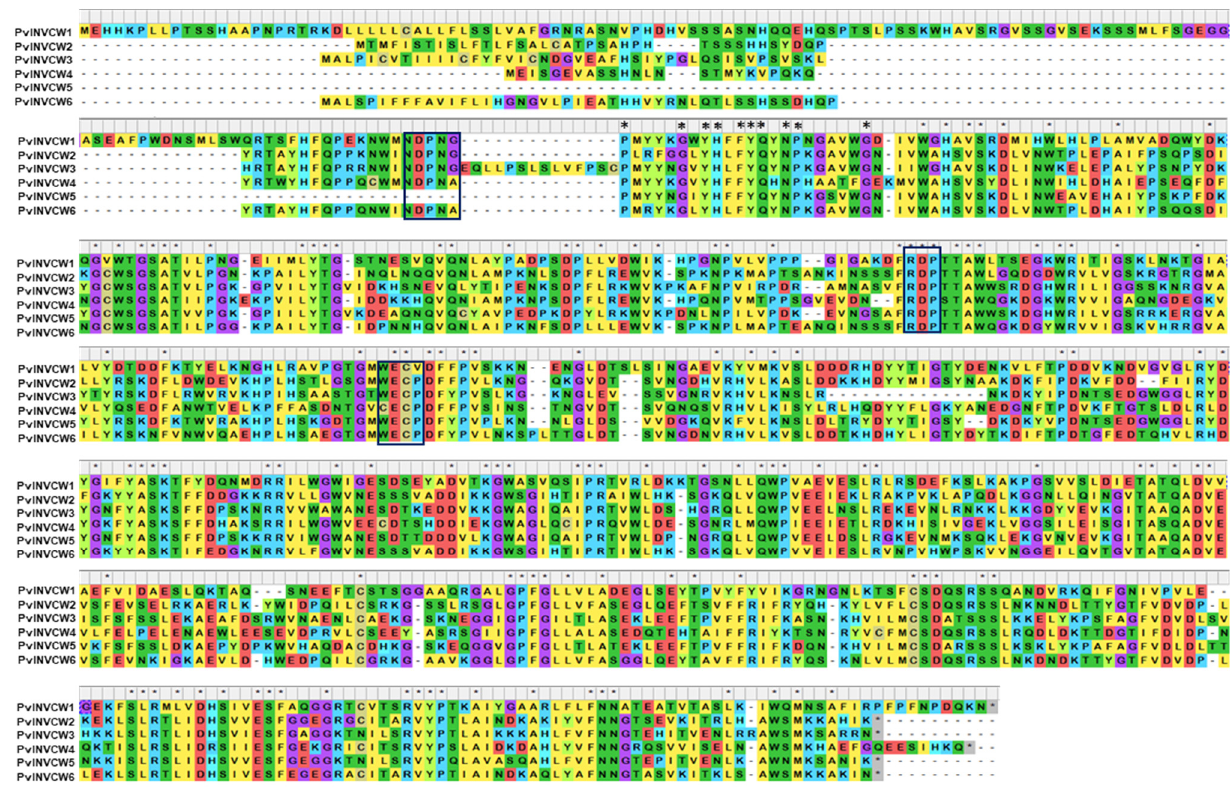
Figure 5. Alignment of deduced amino acid sequences of invertases of Phaseolus vulgaris. Strongly conserved residues are indicated above the alignment with asterisks. Potential glycosylation sites are underlined. The β -fructosidase motif, DPN motif, and cysteine catalytic site are boxed in blue.